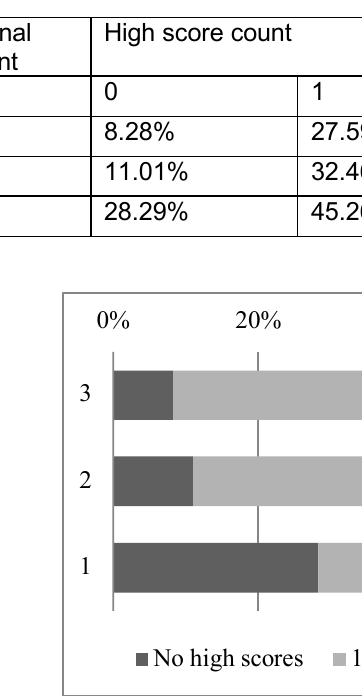
Table 9: Financial Literacy Segments by Educational Attainment